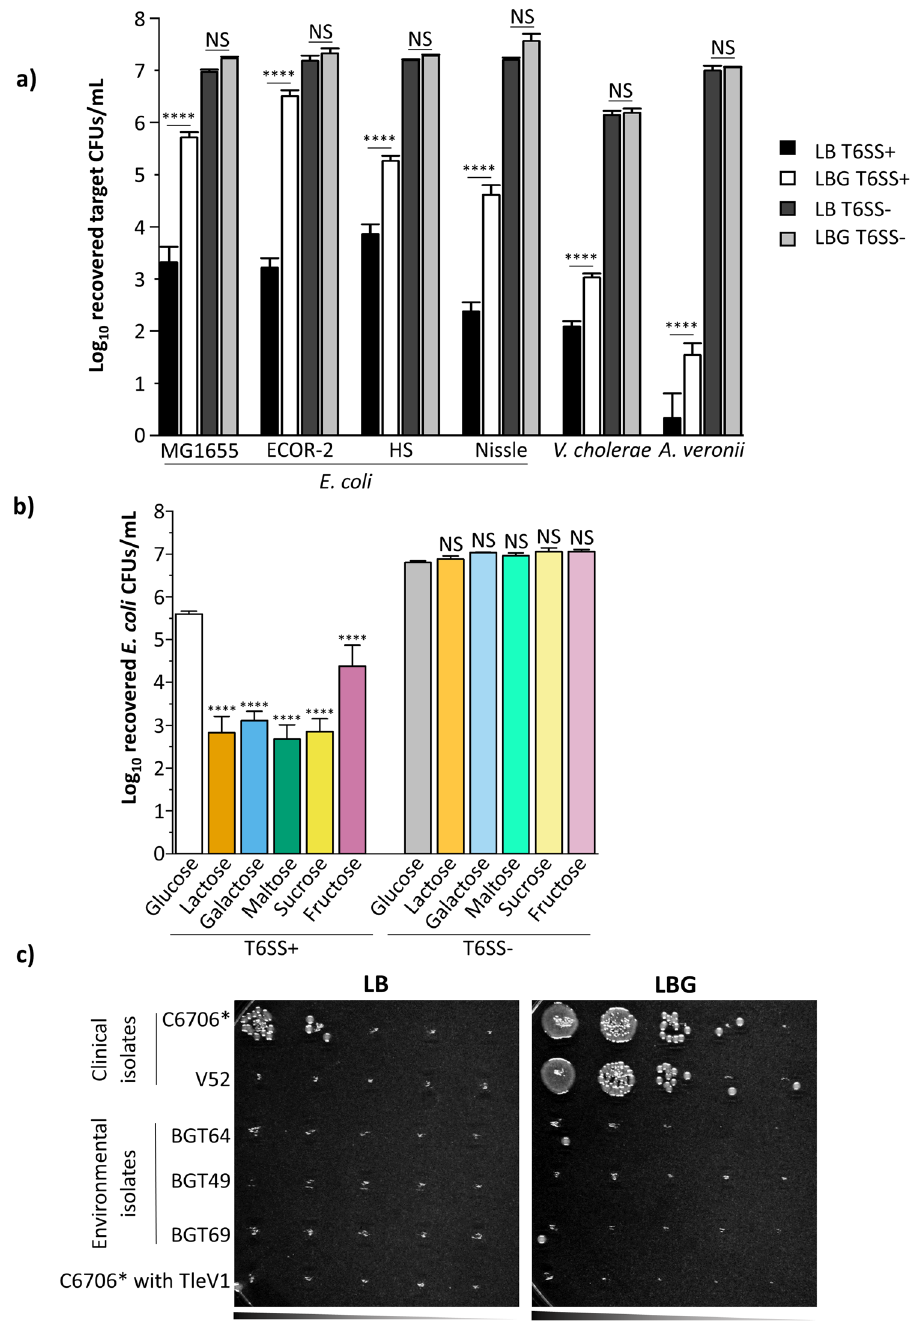
Figure 2. Protection against T6SS attacks depends on the target strain, the killer strain and the sugar substrate. ( a ) Along with MG1655, E. coli commensal strains ECOR-2, HS, Nissle, susceptible V. cholerae and A. veronii target cells were co-cultured with killer V. cholerae C6706* or C6706* T6SS- on LB or LBG. A three-way ANOVA with a Bonferroni post hoc test was performed to determine significance. A minimum of 3 independent replicates were analyzed. ( b ) Killer V. cholerae C6706* cells were co-cultured with E. coli MG1655 cells on LB medium containing 0.4% of the indicated sugar compounds. A two-way ANOVA with a post hoc Tukey HSD test was used to determine significance. A minimum of 3 independent replicates were analyzed. ( c ) Clinical killers V. cholerae C6706*, V52 and C6706* with TleV1, as well as environmental strains BGT49, BGT64 and BGT69 were co-cultured with E. coli MG1655 cells on LB medium (left) or LBG medium (right) and then diluted and plated as described in the “Methods” section. ****p < 0.0001, NS not